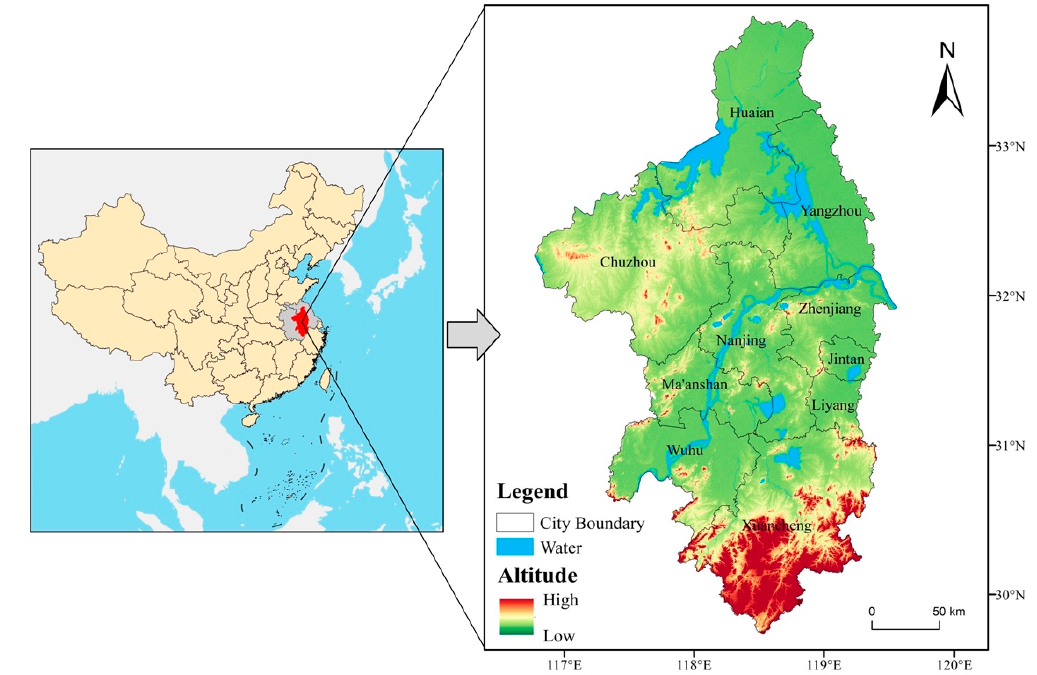
Figure 1. Administrative division and terrain of the study area.